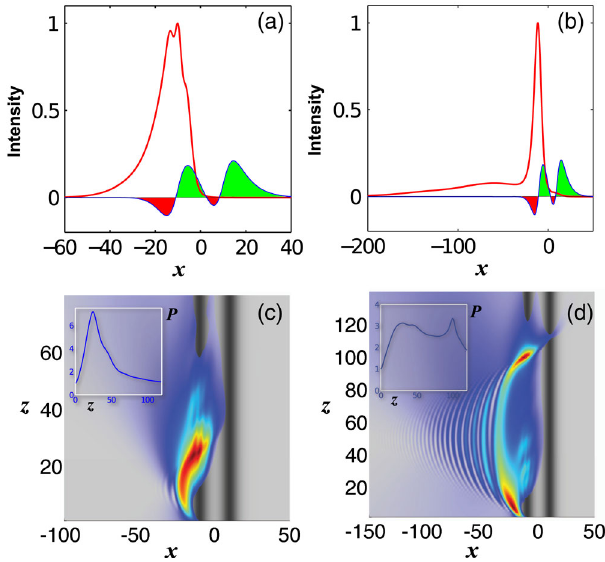
FIG. 6. (a,b) Intensity profiles of two different inputs (thick red curves), along with the imaginary part of the refractive index for reference (thin blue line). (c,d) Beam diffraction dynamics of the corresponding input waveforms in (a) and (b). The two insets depict the optical power versus the propagation distance z for the initial conditions given in (a,b).